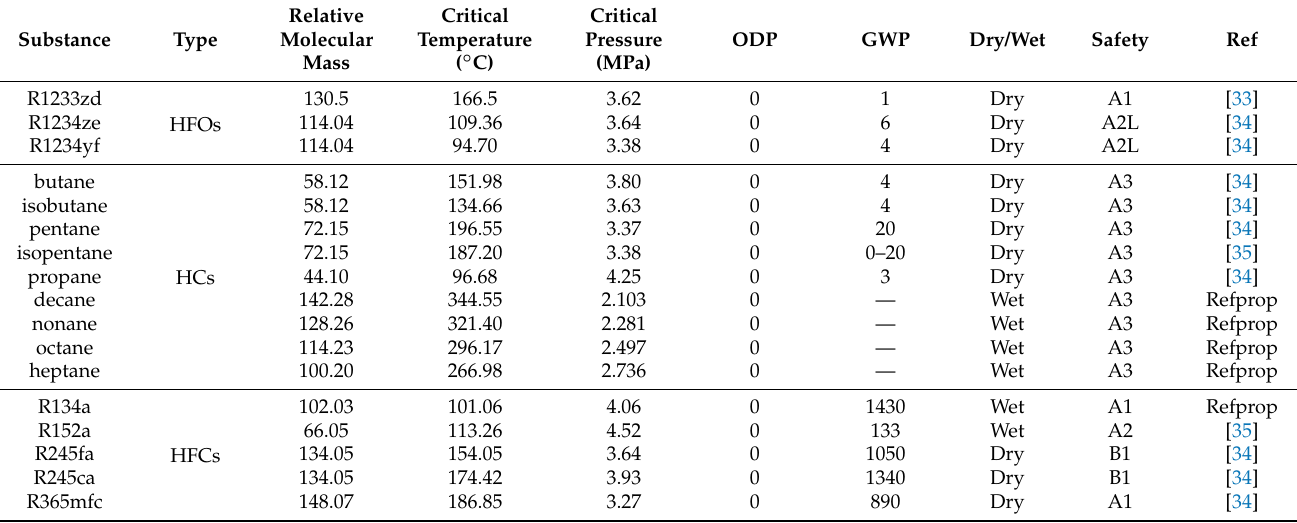
Table 1. Properties of selected working